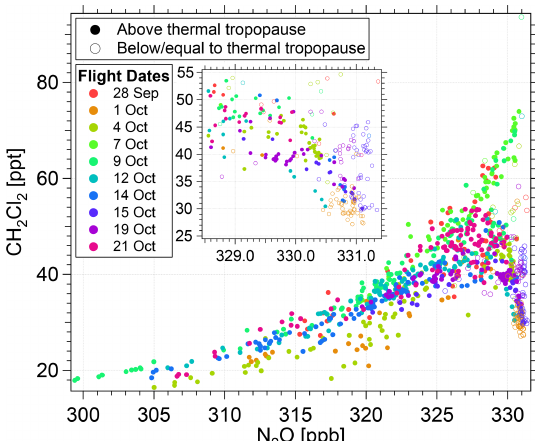
Figure 4. Monthly averaged ground-based measurements of CH 2 Cl 2 from the AGAGE network at Ragged Point, Barbados (13 ◦ N; Prinn et al., 2018), overlaid by a detailed plot of the CH 2 Cl 2 –N 2 O relationship observed during WISE. The AGAGE CH 2 Cl 2 time series (shown in red) shows CH 2 Cl 2 ’s seasonality and is overlaid by the CH 2 Cl 2 –N 2 O relationship such that the CH 2 Cl 2 minimum at N 2 O ≥ 325ppb measured during WISE in Oc- tober 2017 matches the surface CH 2 Cl 2 minimum at Barbados in September 2017. Further, the axis of the time series is adjusted so that 1 month corresponds to a change of ∼ 2ppb N 2 O, which is the typical N 2 O change per month of age in the UTLS (Andrews et al., 2001). The gradient of the CH 2 Cl 2 –N 2 O relationship’s lower branch (low CH 2 Cl 2 mixing ratios between dashed red lines) qual- itatively fits the temporal variation in the ground-based CH 2 Cl 2 measurements. The graph illustrates the congruence of ground- based tropical measurements of CH 2 Cl 2 from the AGAGE network and airborne extratropical measurements of CH 2 Cl 2 from the WISE campaign when assuming that the variation in stratospheric CH 2 Cl 2 with age (here expressed in terms of the N 2 O mixing ratio) arises from the temporal variation in CH 2 Cl 2 at the ground (“tape recorder effect”). Although this simplified view ignores the impact of mix- ing processes and chemical reduction in CH 2 Cl 2 , it qualitatively explains the lower branch of the CH 2 Cl 2 –N 2 O relationship for air parcels younger than a few